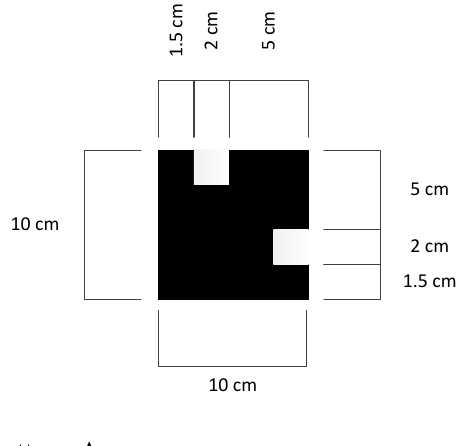
Figure 16. Example Corner Post Schematic (lower left corner